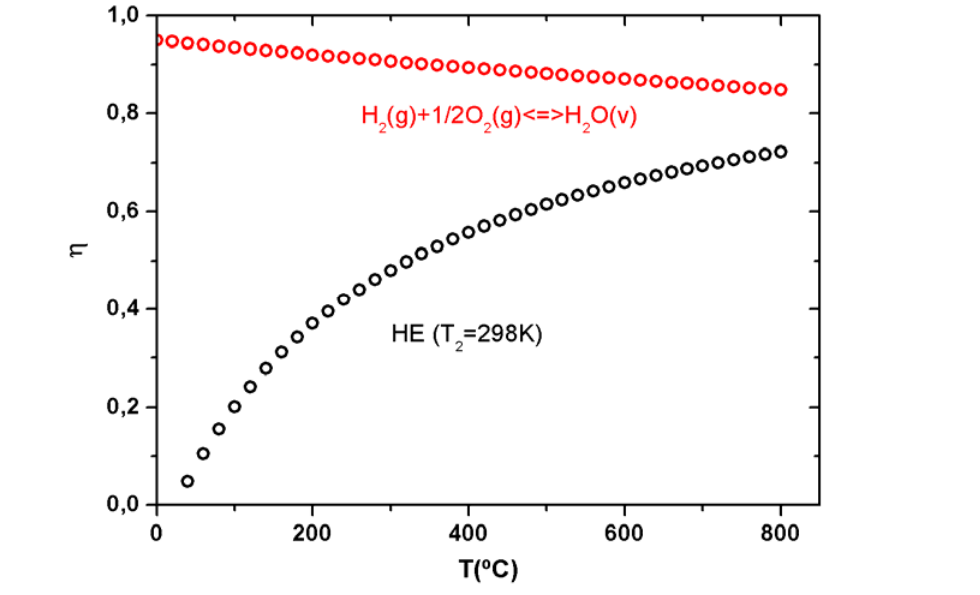
Figure 2. Compared efficiency for a heat engine (black circles) and a fuel cell producing water vapour (red circles), as a function of temperature. The heat engine is supposed to work between a variable hot source and a fixed cold source at room temperature = (T 2